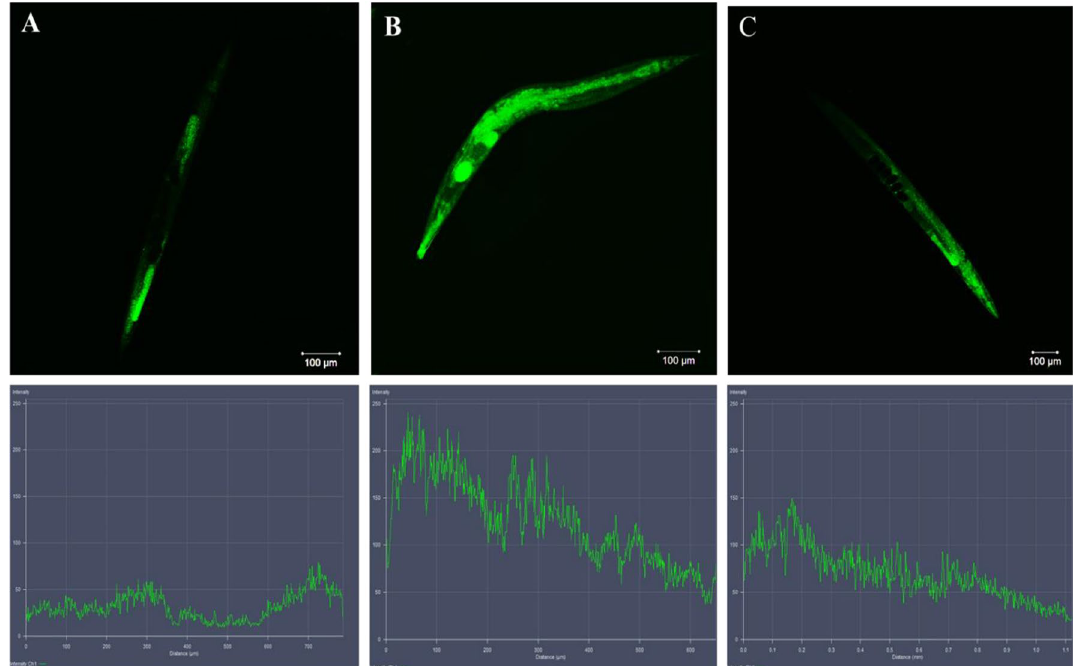
Figure 10. The confocal laser scanning micrographs showing the intestinal accumulation of Serratia marcescens in nematodes with and without quercetin by acridine orange staining method. ( A ) ½ MIC treated, ( B ) control without any treatment ( C ) ¼ MIC treated. The histogram indicates the quantitative amount of intracellular accumulation of Serratia marcescens in